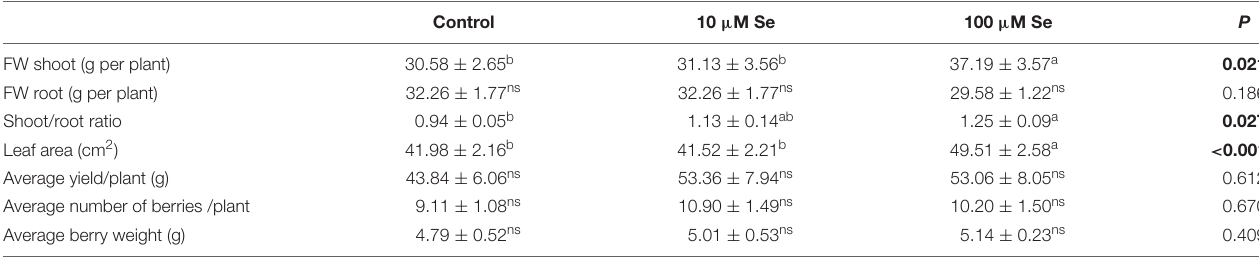
TABLE 1 | Fresh weight, shoot to root ratio, leaf area, average yield per plant, average number of berries per plant and average berry weight of strawberries grown in a full nutrient (control) and a nutrient solution either supplied with 10 or 100 µ M Se.